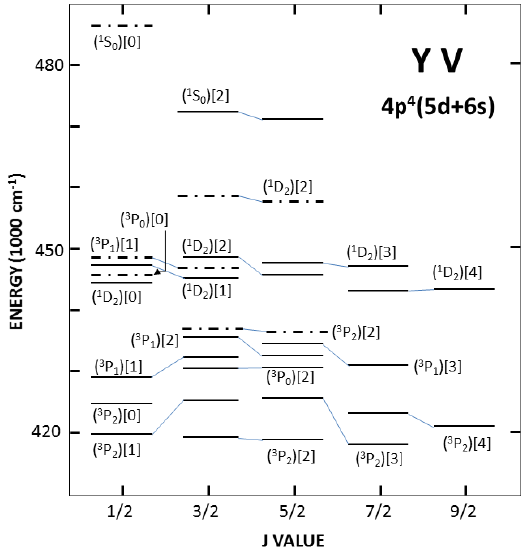
Figure 5. Structures of the 4s 2 4p 4 5d and 4s 2 4p 4 6s configurations of Y V. The 4s 2 4p 4 6s levels are shown as